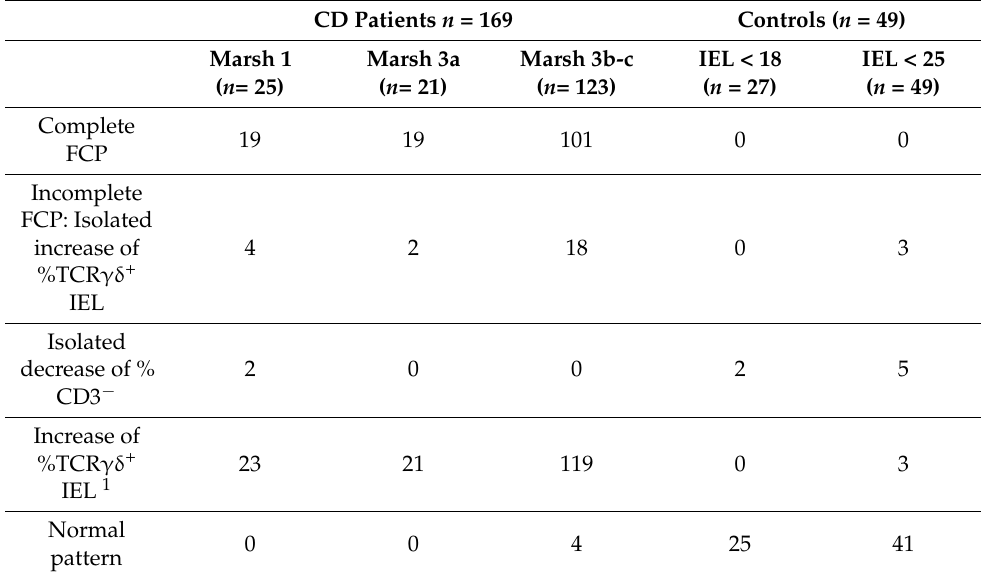
Table 4. Cytometric patterns in CD patients and control